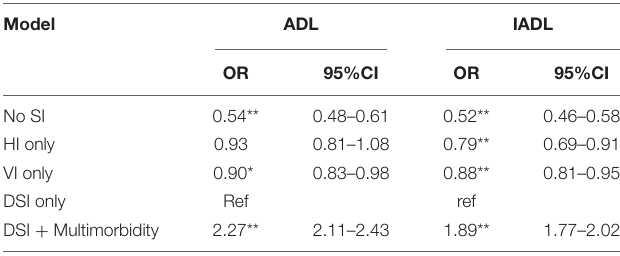
TABLE 2 | Longitudinal associations between functional impairment and the co-occurrence of sensory impairment and multimorbidity ( N = 10,217). Model